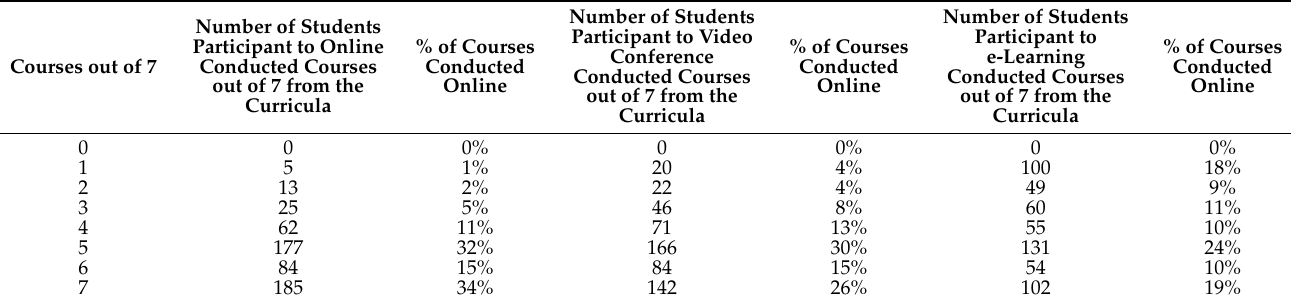
Table 16. Out of the total of 5–7 study disciplines allocated to the first semester of the 2020–2021 academic year, how many of them did you take online courses? (question 13); how many of them have been conducted by teacher through a video conferencing system? (question 14); how many of them have been conducted by teacher through an e-learning platform (virtual classroom or online testing)? (question